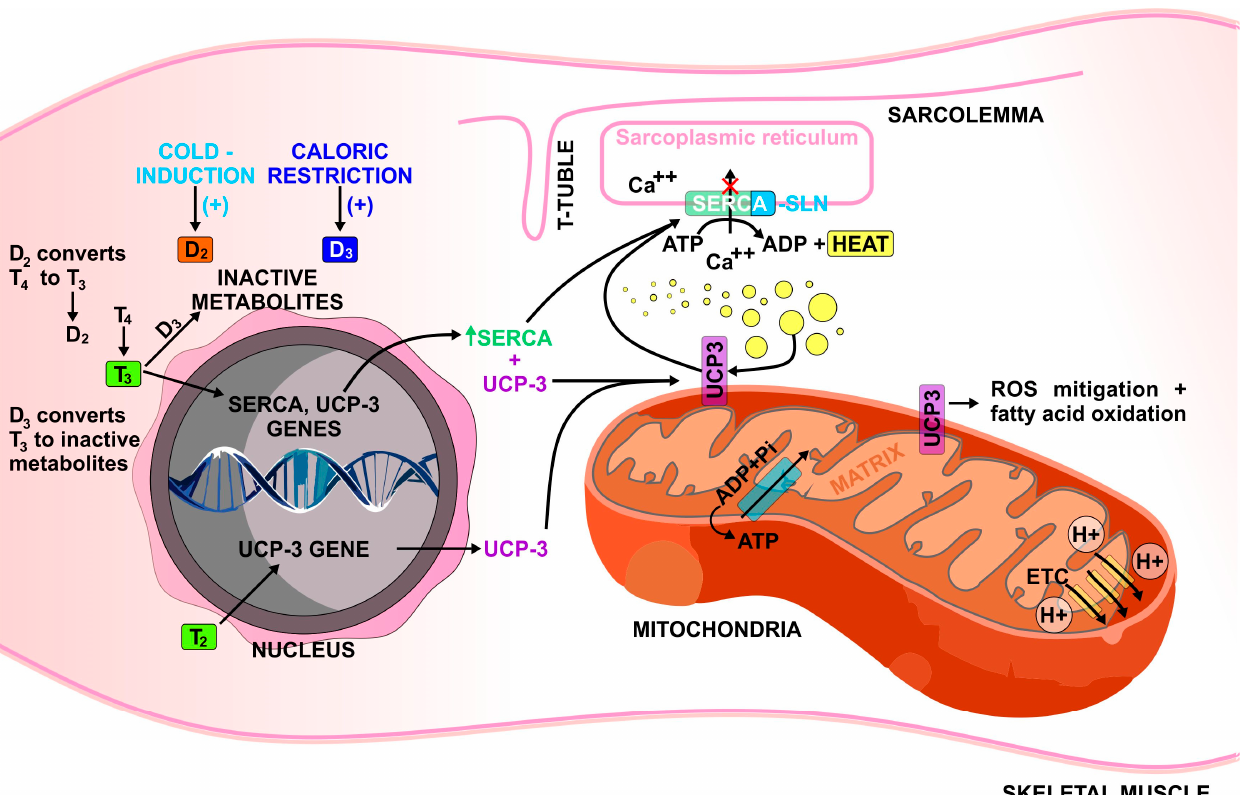
Figure 1. Mechanisms that have been proposed to be responsible for thyroid hormones’ regulation of skeletal muscle thermogenesis. SLN, sarcolipin; D2, type 2 deiodinase; D3, type 3 deiodinase; ADP. Adenosine diphosphate; ATP, adenosine triphosphate, Pi, inorganic phosphate.